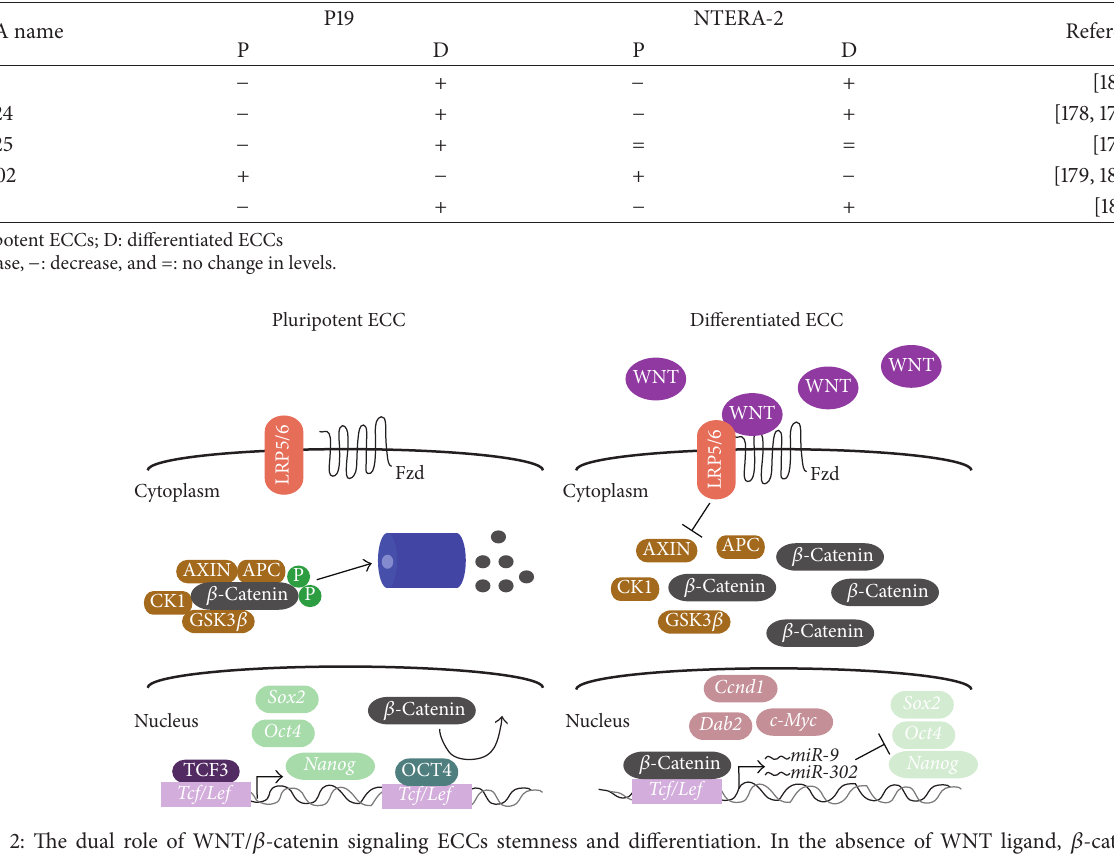
Table 2: Trend of select miRNAs in P19 and NTERA-2 cells.